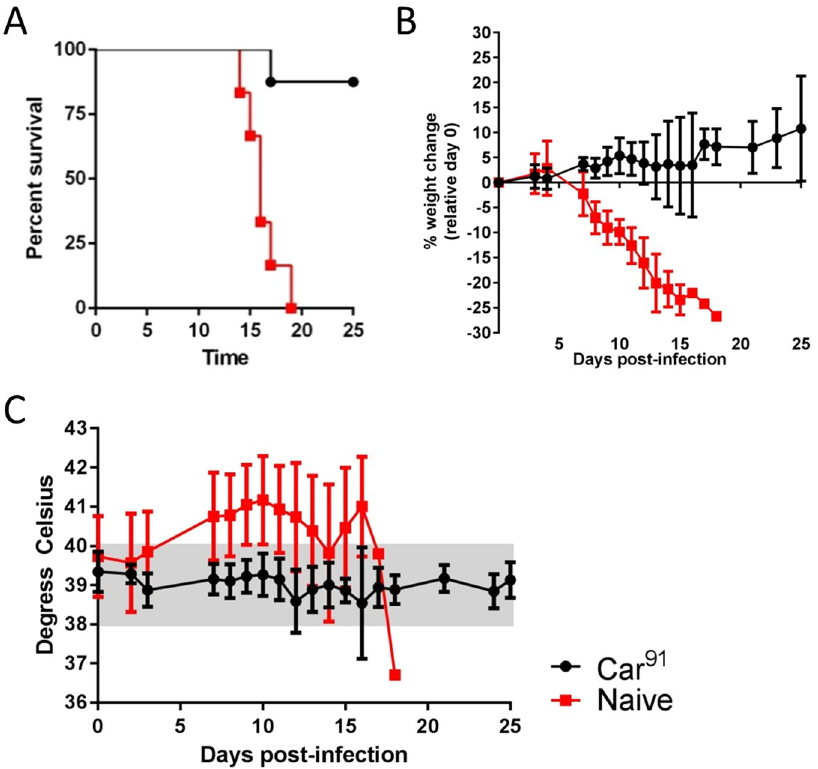
Figure 5. Protective efficacy of MACV strain Car 91 against lethal GTOV challenge in guinea pigs. ( A ) Survival plot of naïve (red squares) and Car 91 -vaccinated (black circles) guinea pigs infected by the i.p. route with 2,000 pfu GTOV. Survival was plotted for 30 day post-infection. ( B ) Percent loss from starting weight was plotted for each group as described above. ( C ) Temperature was monitored as in Fig.